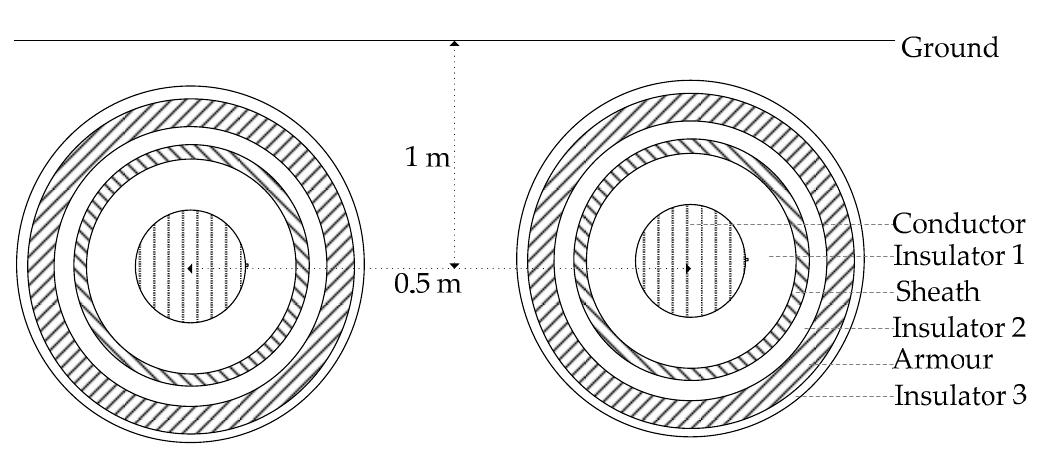
Figure 4. The cross section of a DC cable.